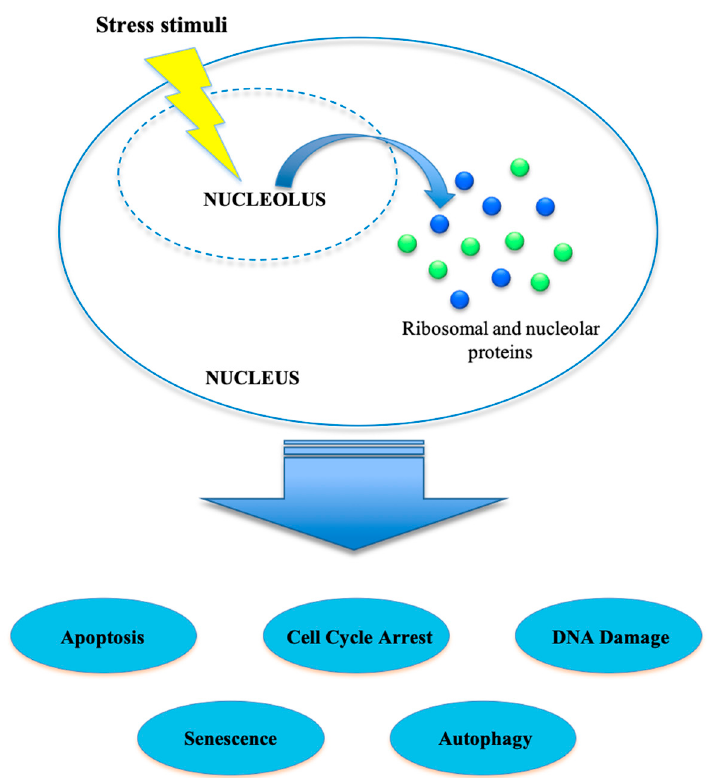
Figure 1. Nucleolar stress. Several stress stimuli can activate a cellular-stress-response pathway known as nucleolar stress. This condition is mediated by different ribosomal proteins and/or nucleolar proteins that are released from the nucleolus to the nucleoplasm, leading, through the activation of specific pathways, to apoptosis, cell-cycle arrest, DNA damage, senescence and/or autophagy.